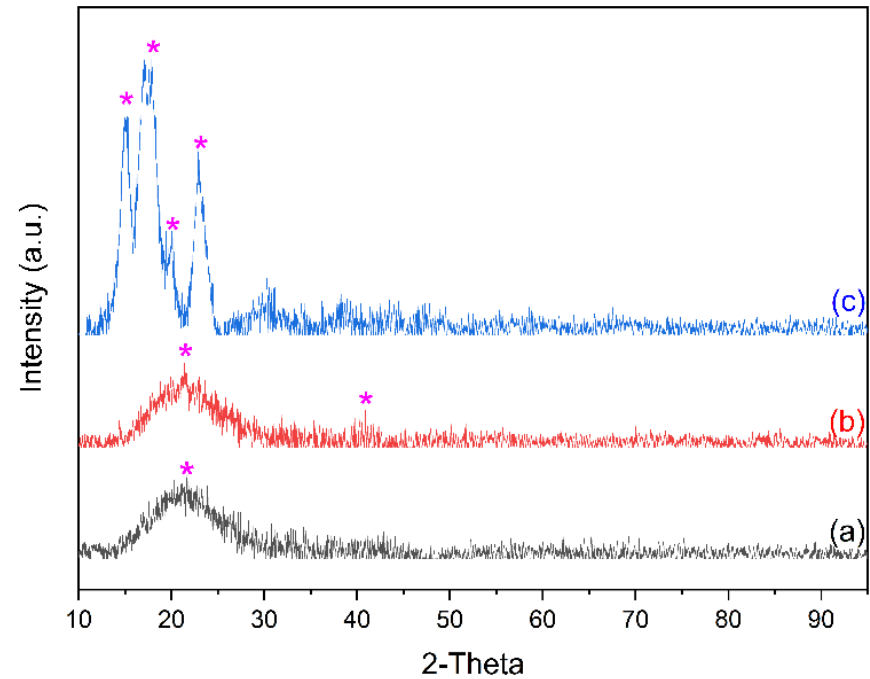
Figure 2. XRD of (a) CQDs, (b) S-CQDs, and (c) S-CQDs/starch.